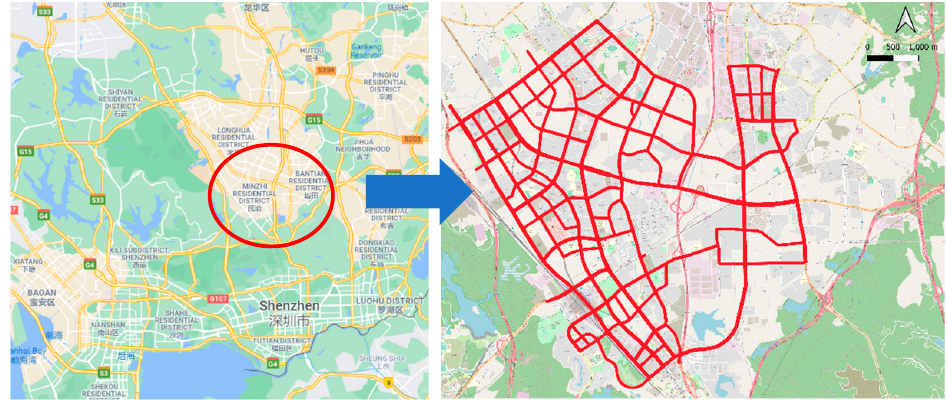
Figure 8. Testing area.